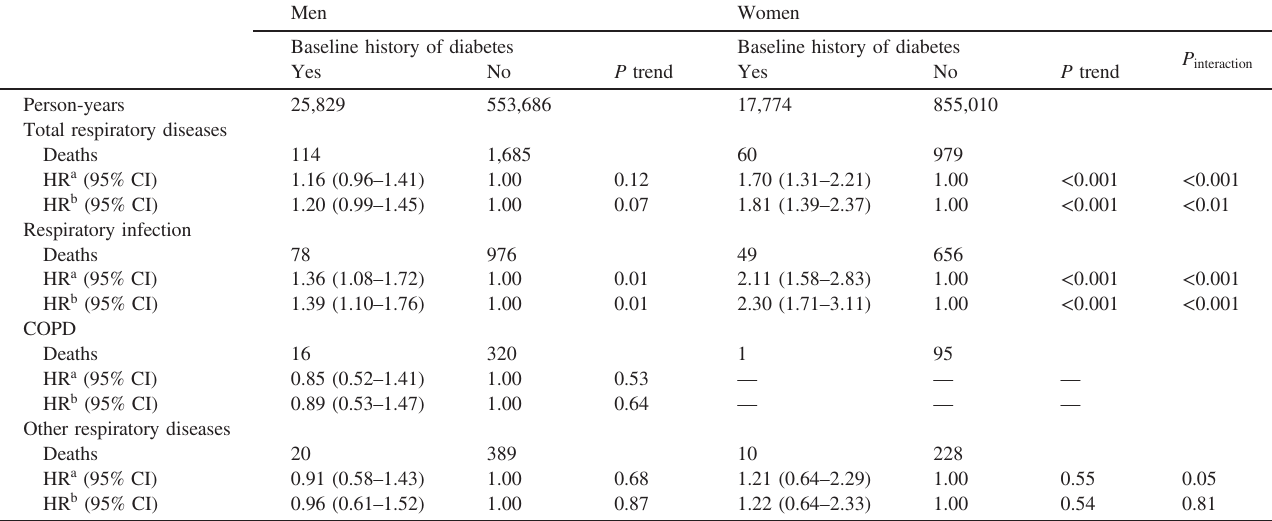
Table 2. Sex-speci fi c and age-adjusted and multivariable hazard ratios (HRs) of mortality from respiratory diseases according to baseline history of diabetes Men